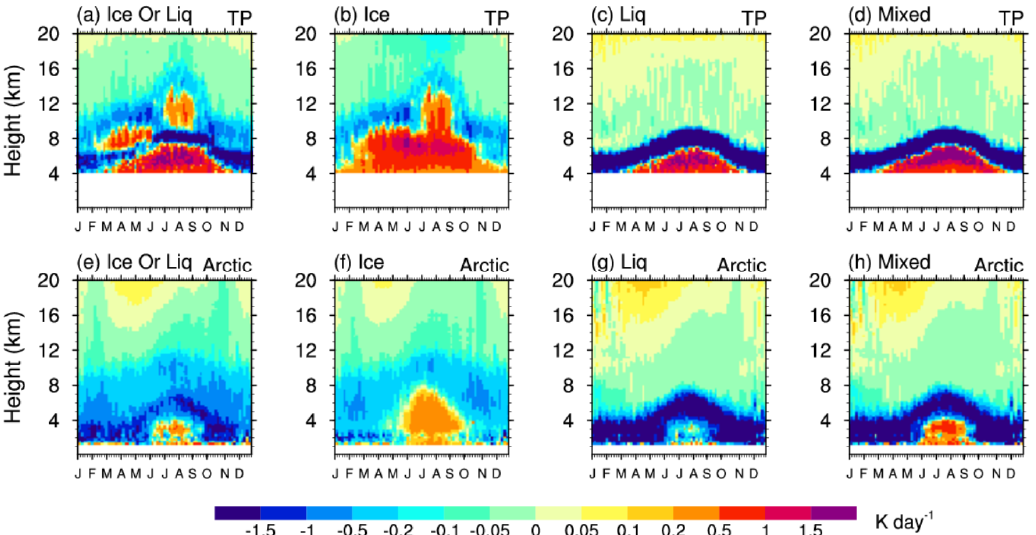
Figure 6. RRTM calculation results for the seasonal cycle of the cloud net (SW+LW) CRE under different sky conditions per unit mass over ( a – d ) the TP and ( e – h ) the Arctic. Panels ( a ) and ( e ) show the cloud ice or liquid water contained in the atmospheric profiles; panels ( b ) and ( f ) show only the cloud ice water; panels ( c ) and ( g ) show only the cloud liquid water; panels ( d ) and ( h ) show only the mixed-phase cloud water layer. Positive and negative values represent the heating and cooling rates, respectively. Unit: K day − 1 .